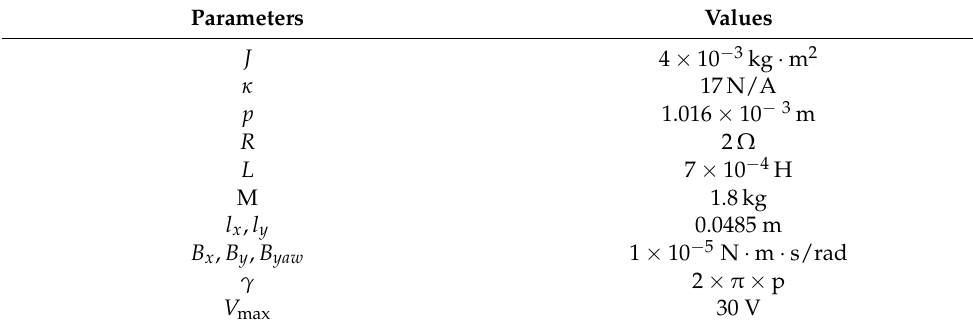
Table 1. Parameters of the planar motor.